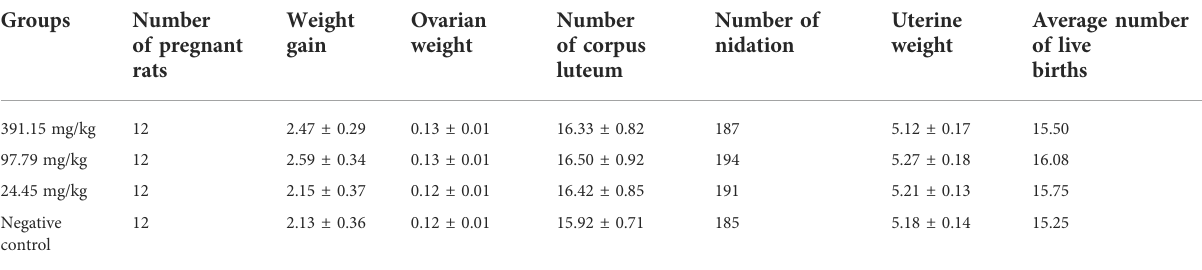
TABLE 9 Effect of MCE on the reproductive performance of pregnant rats.